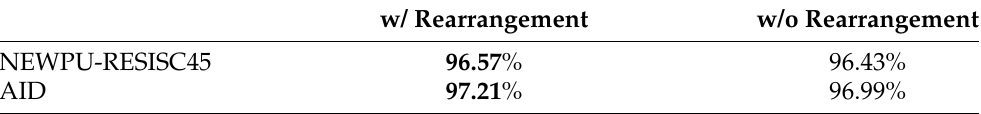
Table 4. Effect of feature maps